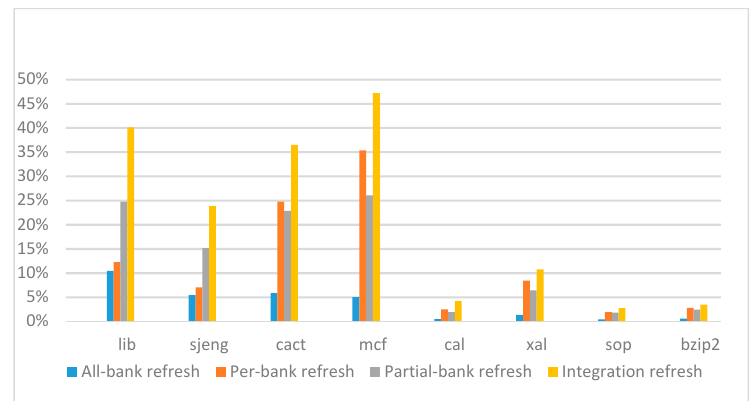
Figure 20. IPC improvement normalized to 1x granularity baseline (tRFC = 890 ns, weak row = 3%).